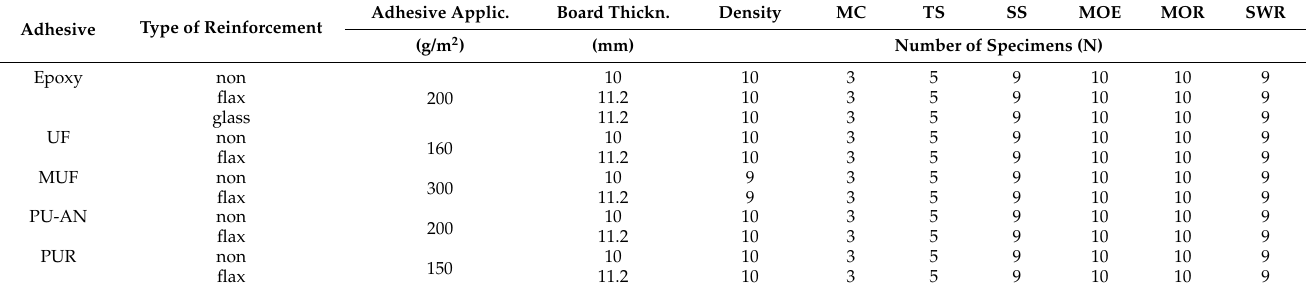
Table 1. Design of the experiment for the influence of adhesive systems on flax fiber reinforced plywood. Adhesive Type of Reinforcement